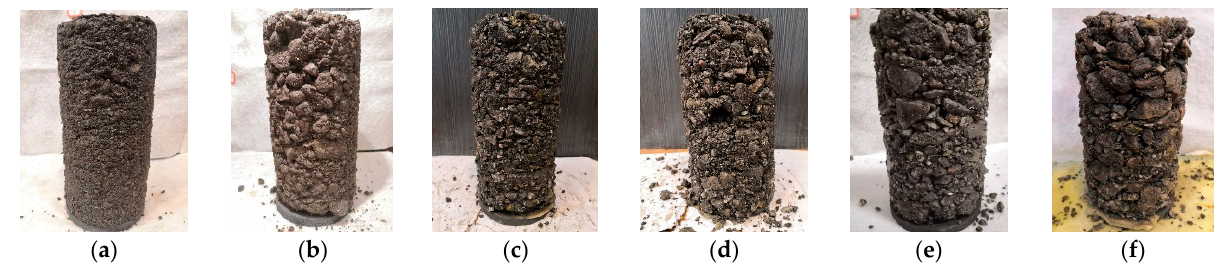
Figure 3. The close-up photos of laboratory specimens with varying G/S values: ( a ) G/S = 1.0 ; ( b ) G/S = 1.6 ; ( c ) G/S = 1.8 ; ( d ) G/S = 2.0 ; ( e ) G/S = 2.2 ; and ( f ) G/S = 2.5.